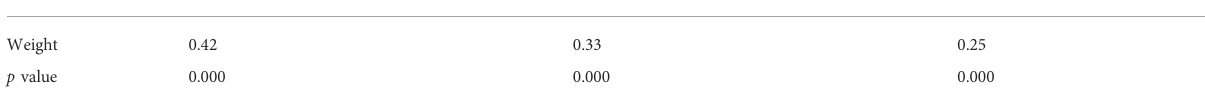
TABLE 1 Scenic spot weight statistics.